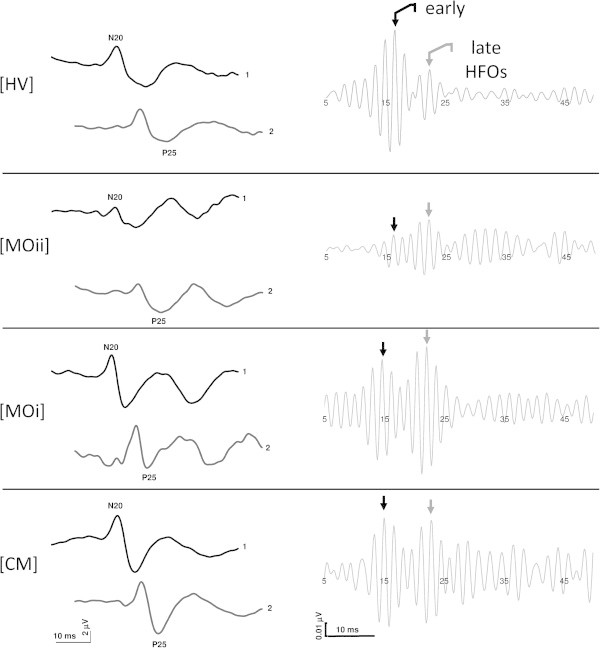
Schematic representation of the changes in somatosensory evoked potentials (SSEPs) N20-P25 amplitude habituation (left panel) and early and late high-frequency oscillations (HFOs) (right panel) in patients in comparison to the responses obtained from a healthy volunteer. (HV, healthy volunteer; MOii, migraine without aura between attacks; MOi, migraine during the attack, CM, chronic migraine).